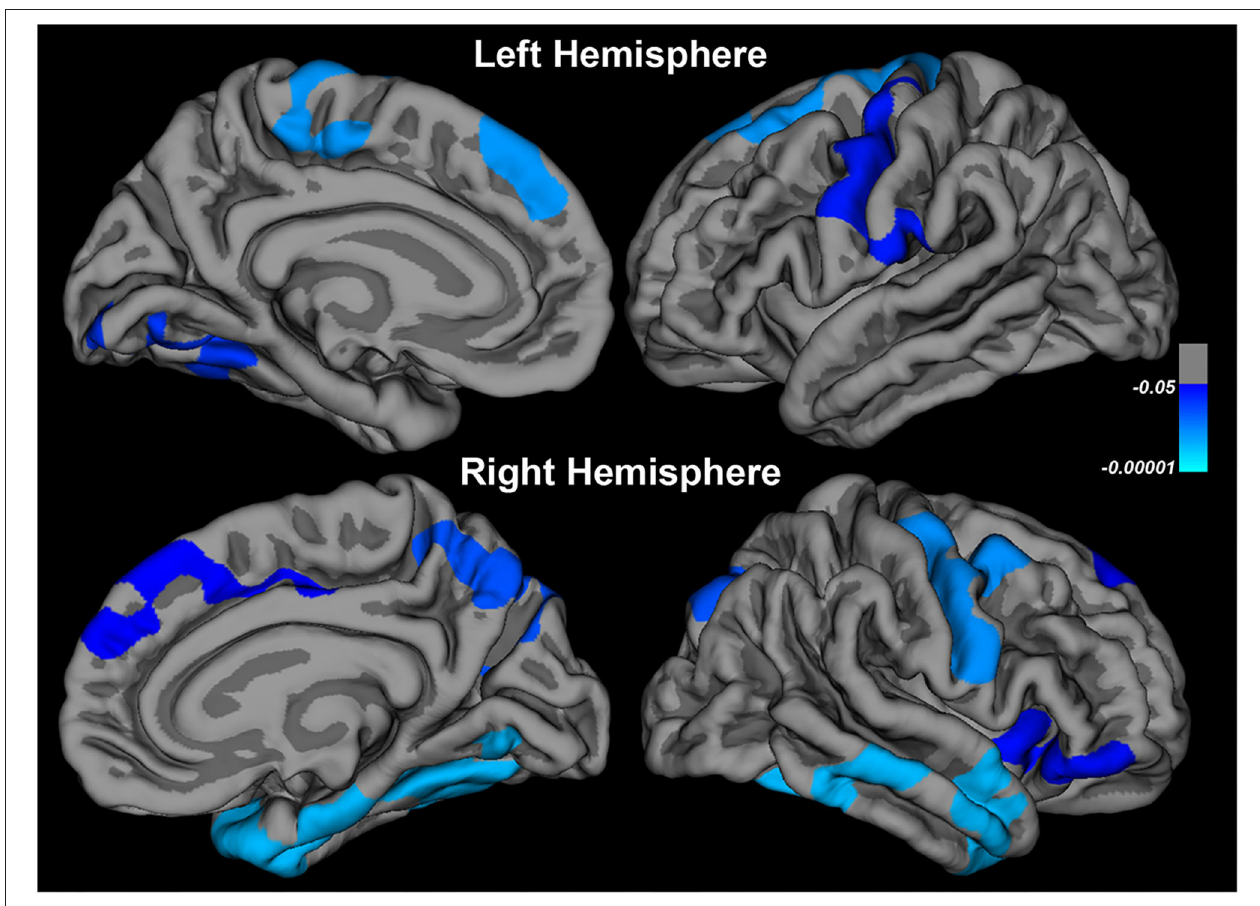
FIGURE 1 | Changes in cortical thickness in patients at baseline compared to